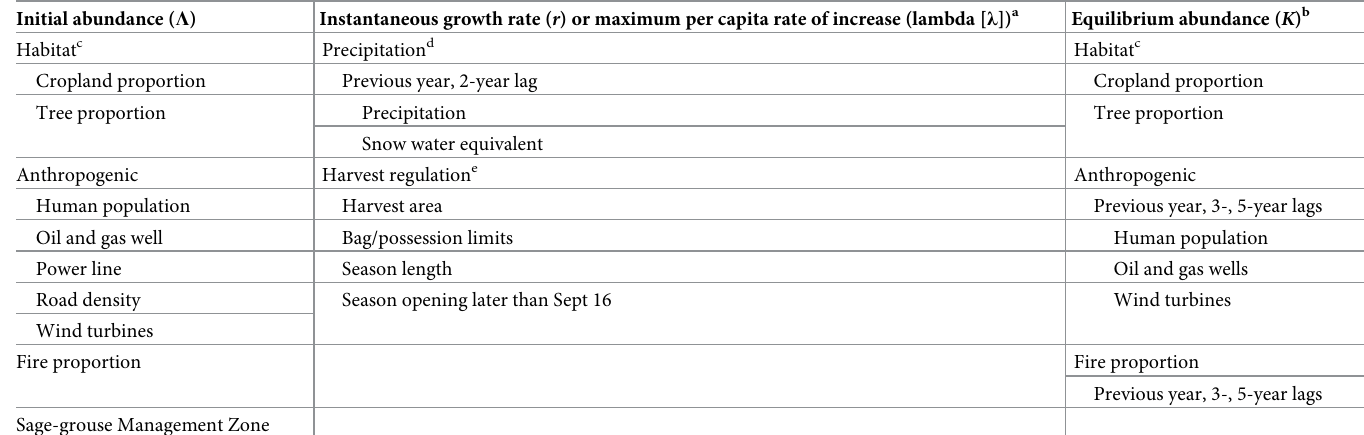
Table 3. Sets of variables considered as predictors in models. N-mixture models included explanatory variables estimating initial abundance ( Λ ) were lek specific and related to 1995 (except Λ for Never 1996 was related to 1996). Models with density-dependent dynamics (Gompertz or Ricker models) included time-varying variables pre- dicting instantaneous growth rate ( r ) and equilibrium abundance ( K ). Whereas, models with exponential growth dynamics included time-varying variables predicting maximum per capita rate of increase (lambda [ λ ]). Explanatory variables were spatially explicit to each sage-grouse lek with time-varying variables aligned temporally as near to data acquisition date as possible,